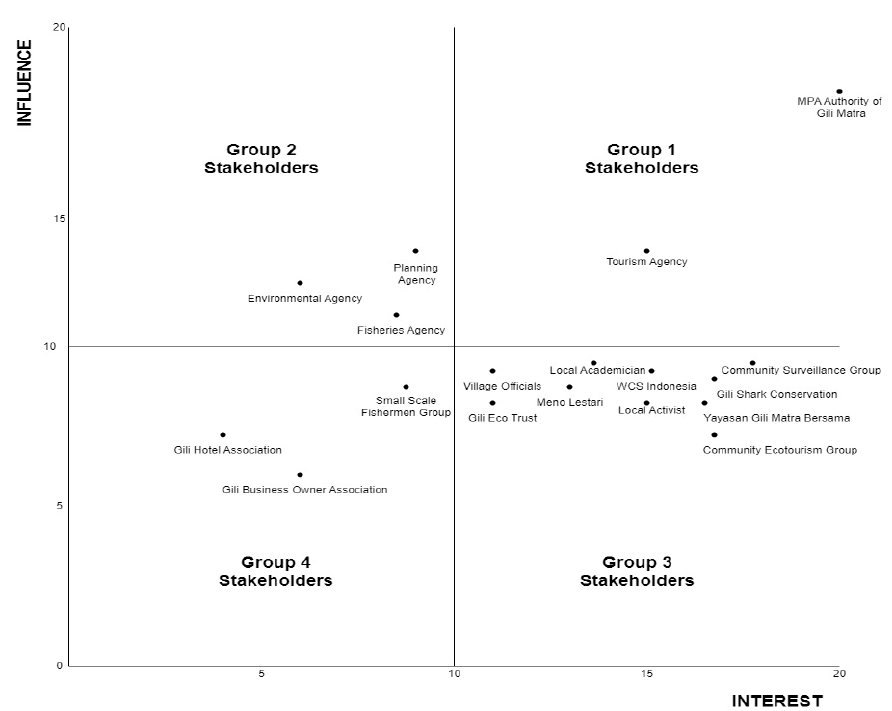
Figure 3. Matrix of stakeholder mapping results in the Gili Matra MPA. Out of eighteen stakeholders, only five of them are considered to have a significant influence score and possess authoritative work in the MPA, while the rest are considered as non-influential stakeholders.